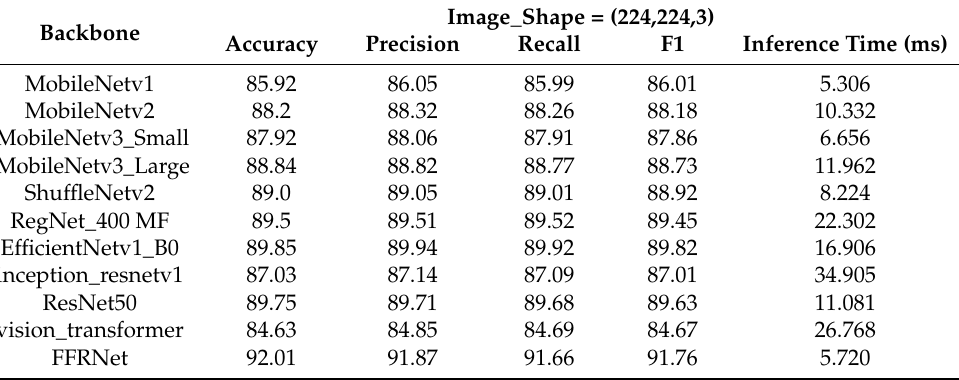
Table 9. Comparative experiment of different models and FFRNet. In addition to the real-time inference speed, FFRNet achieved the best results. Although FFRNet (5.720 ms) was slower than MobileNetv1 (5.306 ms), after weighing accuracy, we think it is acceptable to lose a little bit of speed to guarantee extremely high accuracy.